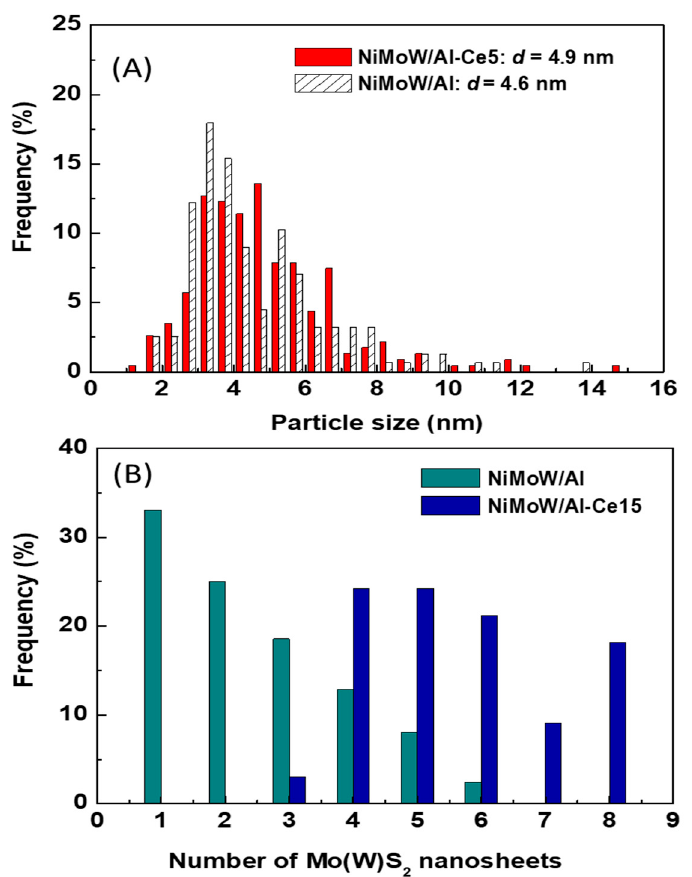
Figure 13. Statistical TEM analysis of the particle size ( A ) and number of Mo(W)S 2 nanosheets ( B ) of the used catalysts .